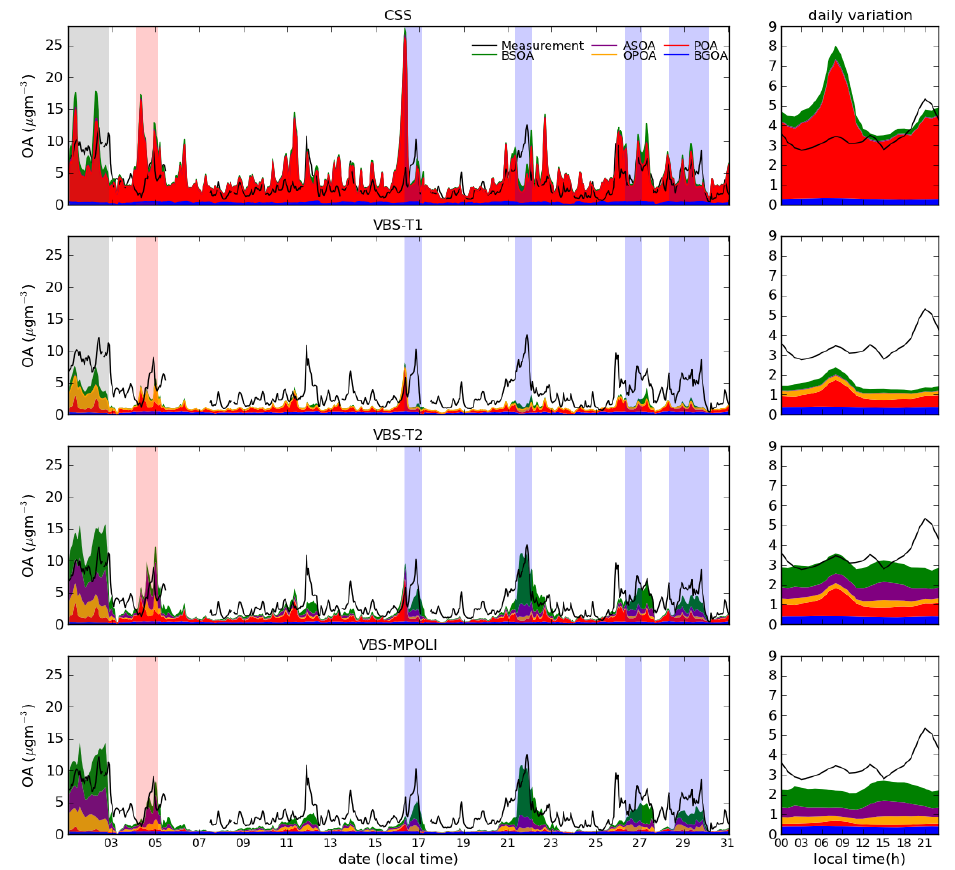
Fig. 8. As in Fig. 7, but for